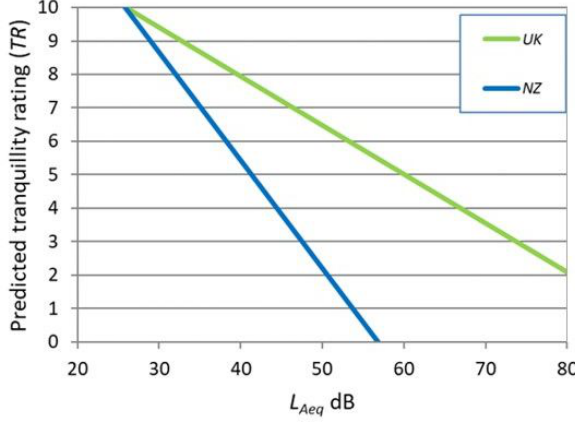
Figure 5: Comparison of trend lines from UK and NZ studies